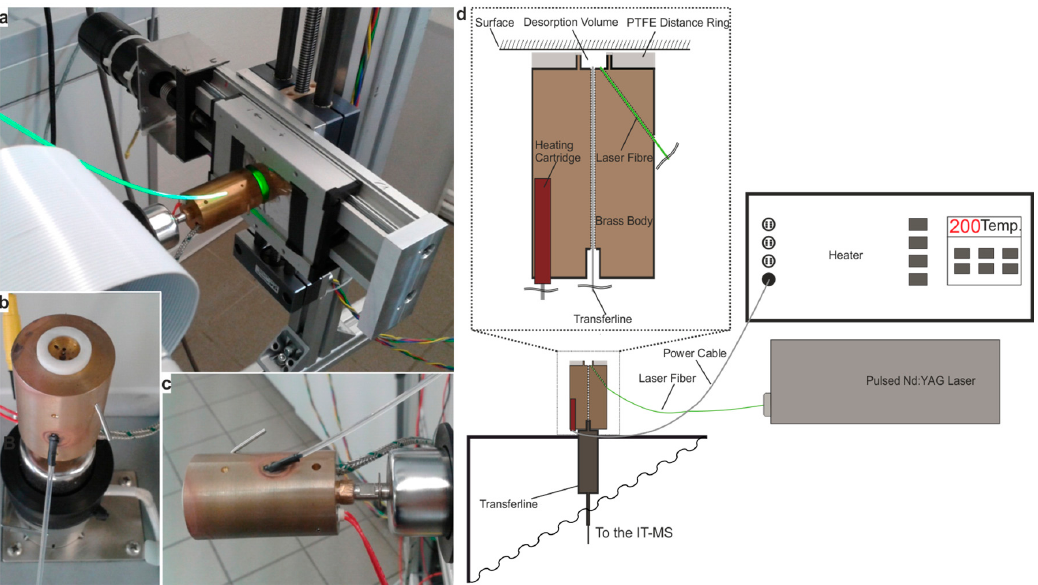
Figure 1. ( a ) Laser desorption sampling for mass spectrometric analysis from a stainless steel surface